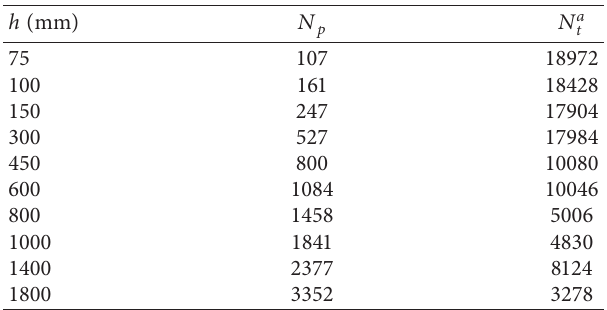
Table 4: Simulations performed in the case with periodic BC for a fixed hopper angle α � 50 ° and various particle bed heights h .